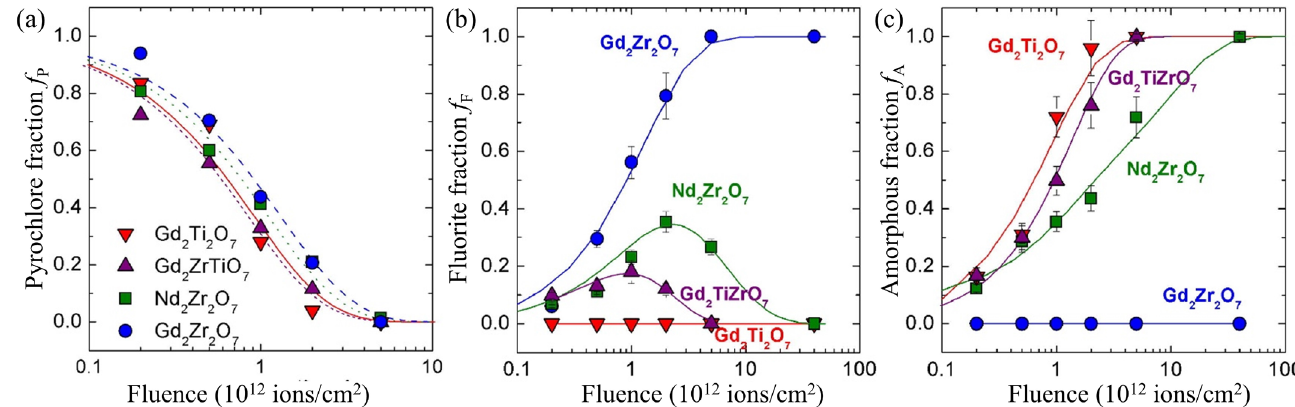
Figure 11. Variation of the fraction of ( a ) pyrochlore, ( b ) fluorite, and ( c ) amorphous phases vs the ion fluence for pyrochlores irradiated with 120 MeV U ions. Solid lines are fits to the data with HTOM (Equation (20a–c)). Reproduced with permission from Reference [142], Copyright © Elsevier 2012.